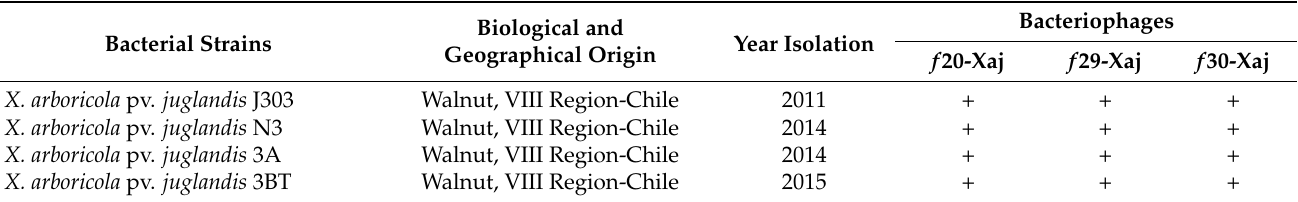
Table 1. Bacteriophage specificity to different bacteria isolated from walnut trees. The bacterial identification was generated by sequencing the 16S rRNA portion or specific